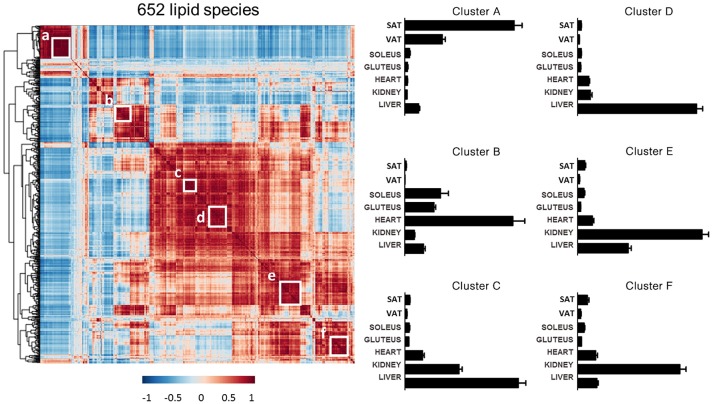
Cluster analysis of lipid profiles. Left: heat map of Pearson correlation matrix across the 652 targeted lipids with corresponding hierarchical tree. White boxes indicate lipid clusters chosen for further analysis. Right: Concentration of lipid clusters across all the tissues analyzed. For the information about the lipid species in each lipid cluster see Table S3.